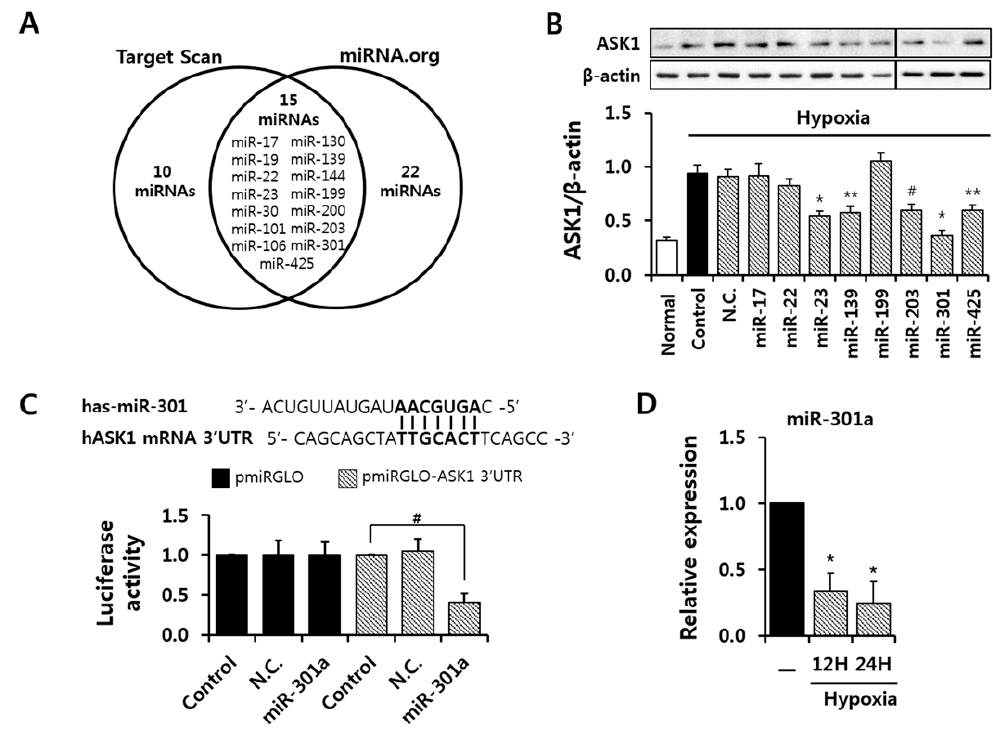
Figure 2. Screening of predicted miRNAs for targeting ASK1. ( A ) Candidate miRNAs that target ASK1 were selected based on prediction databases (www.TargetScan.org & www.microRNA.org);